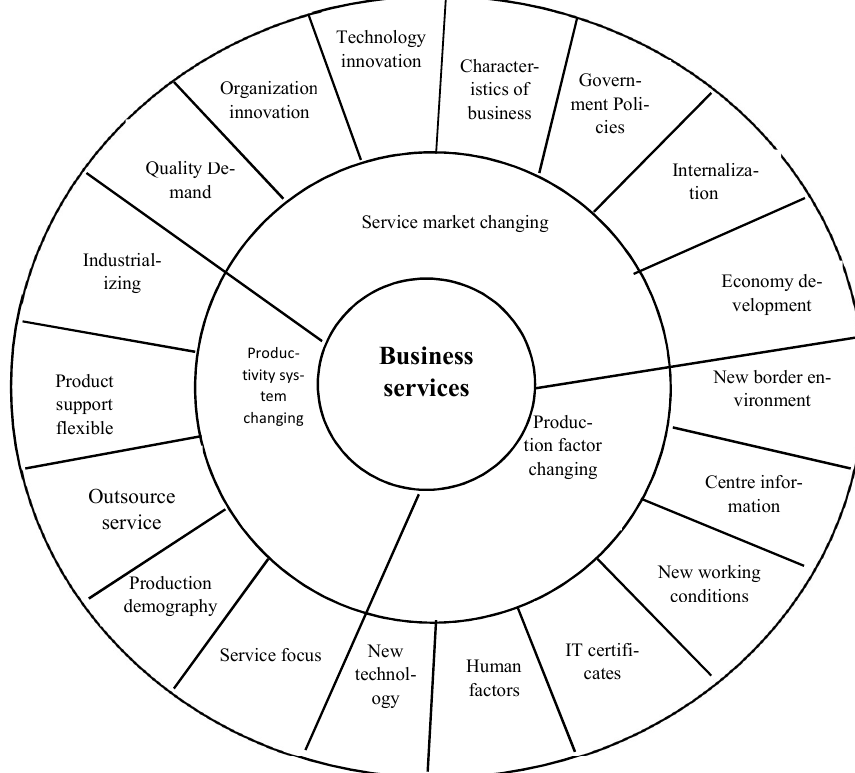
Fig. 1. Factors affecting business service